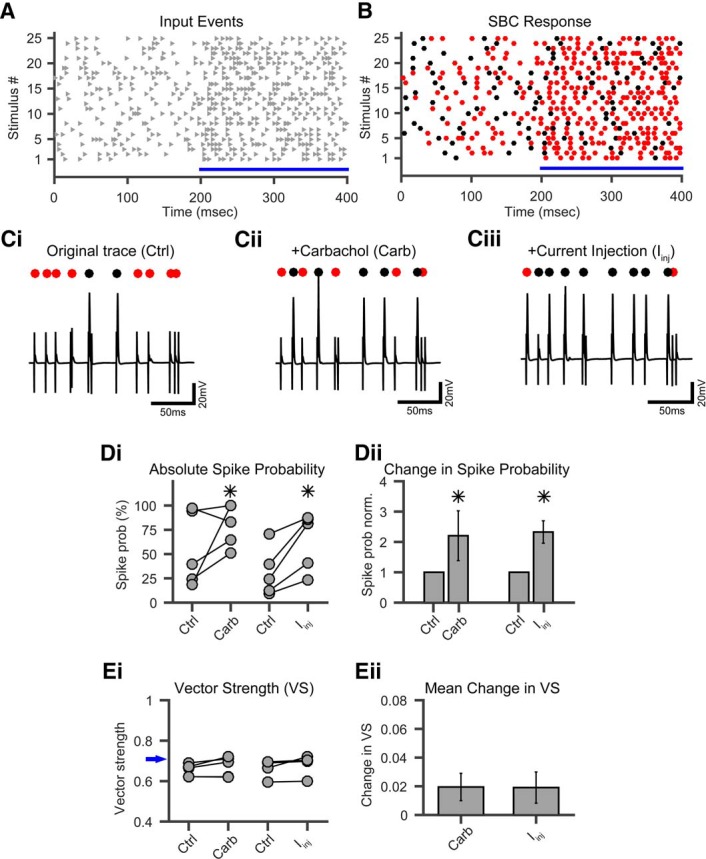
Cholinergic modulation increases SBC spike probability in vitro without a loss in temporal precision. A, Twenty-five repetitions of IVL stimuli were successively presented with a 3 s interval. Gray triangles, input spikes. B, Example response of one SBC to the IVL stimulus paradigm. Red dots, Failed AP; black dots, successful AP. C, Excerpts from IVL stimulus 18 under control conditions (Ci), under cholinergic modulation via carbachol (Carb; Cii), and with elevated RMP through Iinj (Ciii). Note the increase in spike probability. Markers, Red dots, failed AP; black dots, successful AP. Calibration: 20 mV and 50 ms. D, Increase in spike probability under cholinergic modulation. Di, Absolute change in spike probability for cholinergic modulation (Carb) and for RMP elevation through Iinj. Asterisks indicate significant difference (p < 0.01, paired t test). Dii, Mean relative change in spike probability for all cells in Di. Spike probability is increased twofold compared with control for both conditions. Asterisks indicate significant difference (p < 0.01, paired t test). E, Changes in vector strength under cholinergic modulation and RMP elevation. Ei, No significant change in absolute VS of SBC output for cholinergic modulation or RMP elevation was observed (p > 0.7, paired t test). Blue arrow denotes input-VS from the IVL stimuli. Eii, Only a slight, but not significant (p > 0.7, paired t test), increase in mean VS could be seen for both conditions.